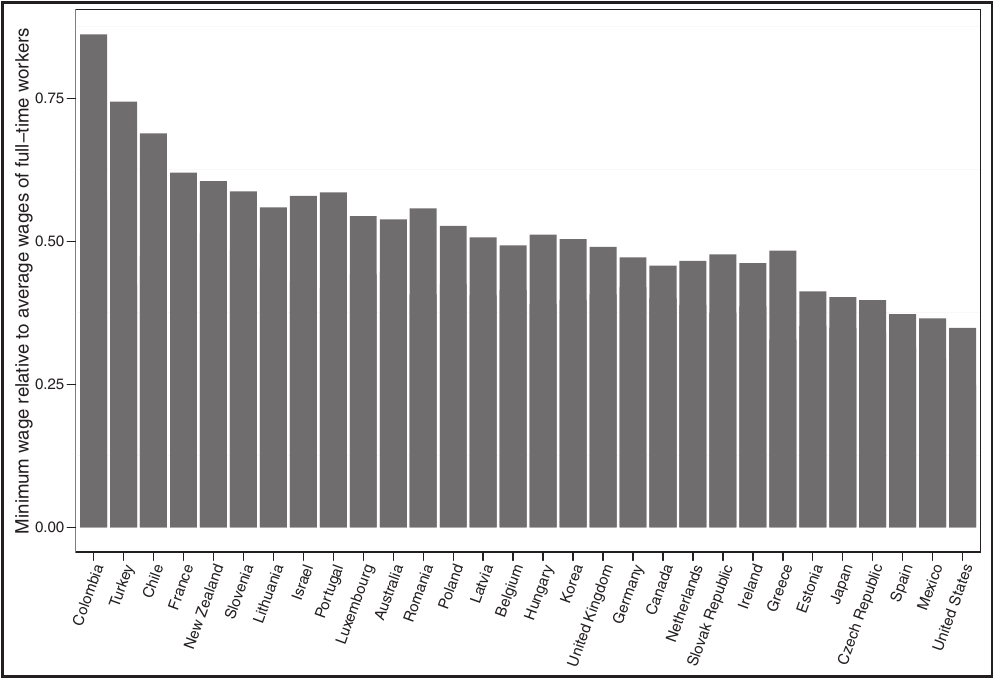
Figure 1 National minimum wage/average wage